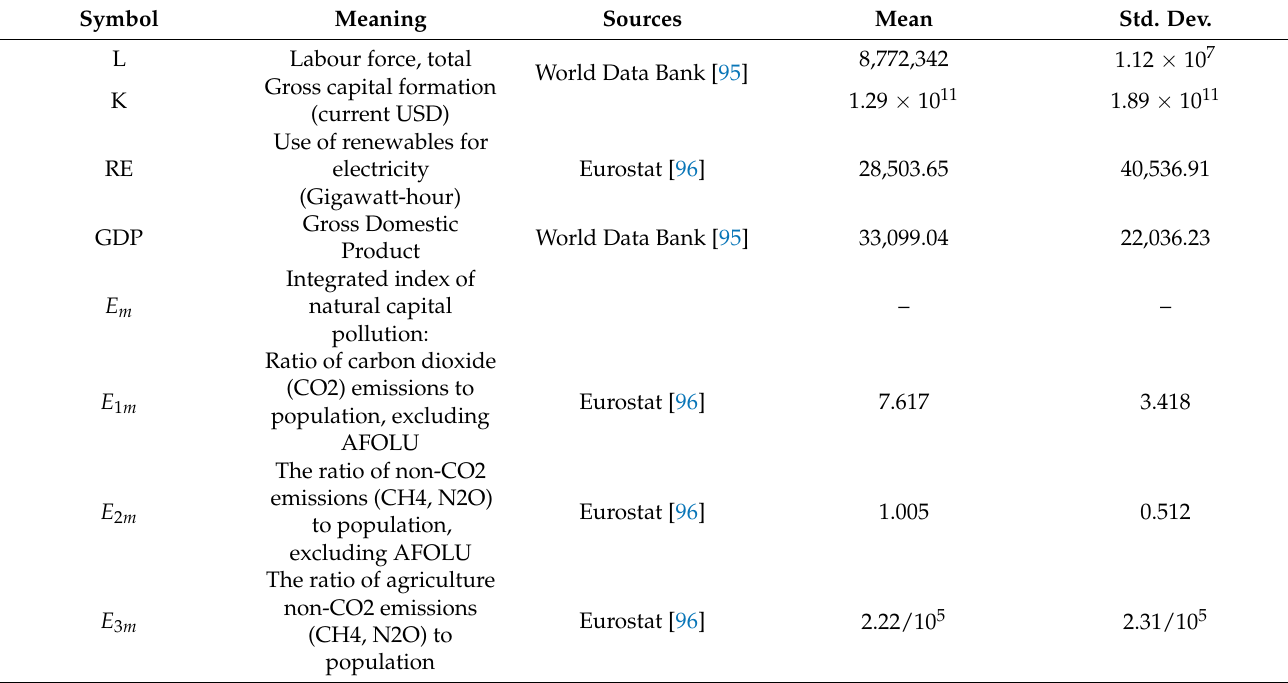
Table 1. Variables of the green economic growth